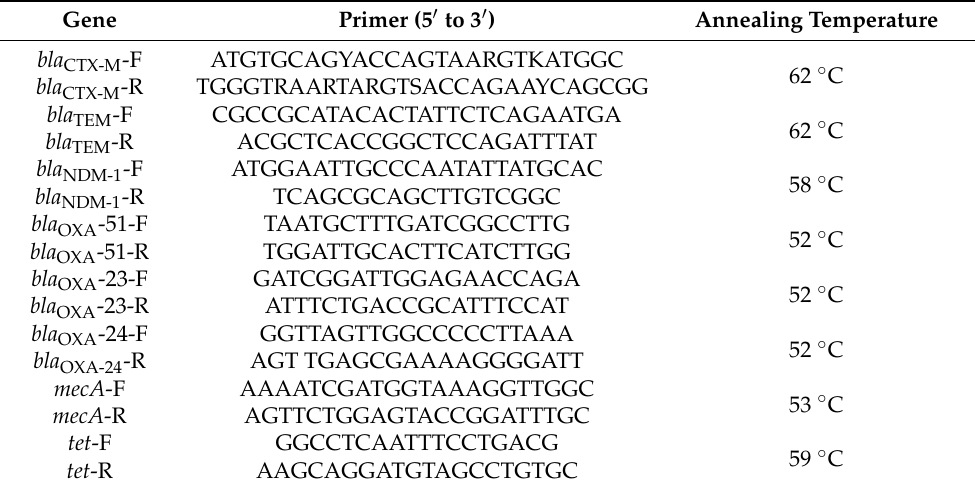
Table 1. Primers used for the identification of antimicrobial resistance genes. Gene Primer (5 (cid:48) to 3 (cid:48)